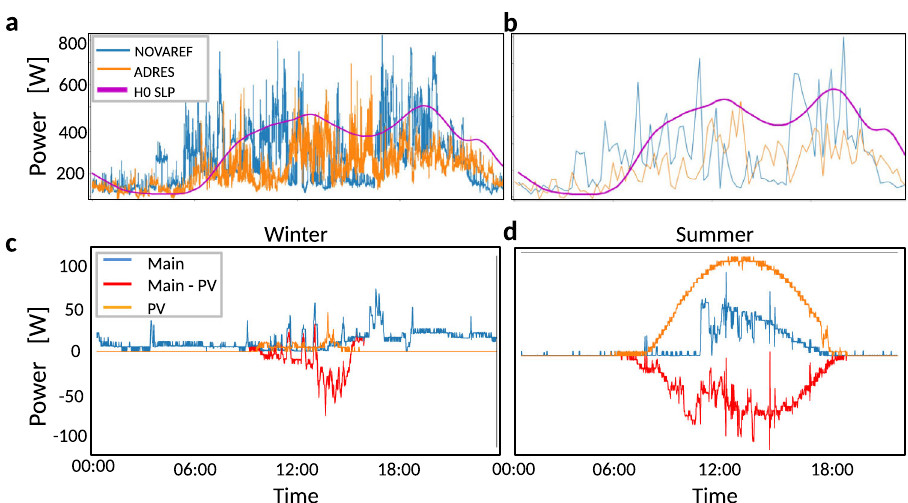
Fig. 1 Systematic, asymmetric and intermittent deviations of empirical power consumption dynamics and German standard load pro fi le (H0 SLP). a We compare the H0 SLP with the averaged real consumption data of a single day in winter for the NOVAREF project, the German dataset recorded between 2013 and 2016 including 12 houses, and ADRES project, the Austrian dataset recorded between 2009 and 2010, including 30 houses. The averaged real consumption data are created by taking the recorded electricity consumption of all houses in the measured time interval and, then, evaluating ∑ N ð t Þ , where P P avg ð t Þ ¼ 1 P h h i is the measured electricity consumption of each house and N is the number of houses, which is respectively 12 and 30 for i N i the NOVAREF and ADRES data. All three datasets were upsampled to a sampling rate of 2 s (0.5 Hz). The H0 SLP not only fails to capture the correct daily trend, but we also observe large fl uctuations of the consumption at short time scales. b Shows the same datasets at 15-min resolution to emulate the temporal resolution that was used to generate the H0 SLP. Here the failure of the H0 SLP to capture the correct daily trend is even more pronounced. c , d show respectively the recorded household power consumption in winter (January 1, 2017) and summer (June 30, 2017) with and without photovoltaics as well as the electricity generated by the PV module installed on the roof of a house at a sampling rate of one minute (PV data source: 70 ). Note the smaller spikes visible in panels ( a , b ) because the data is averaged over 12 and 30 houses, respectively, for NOVAREF and ADRES, while in panel c and d only a single household is